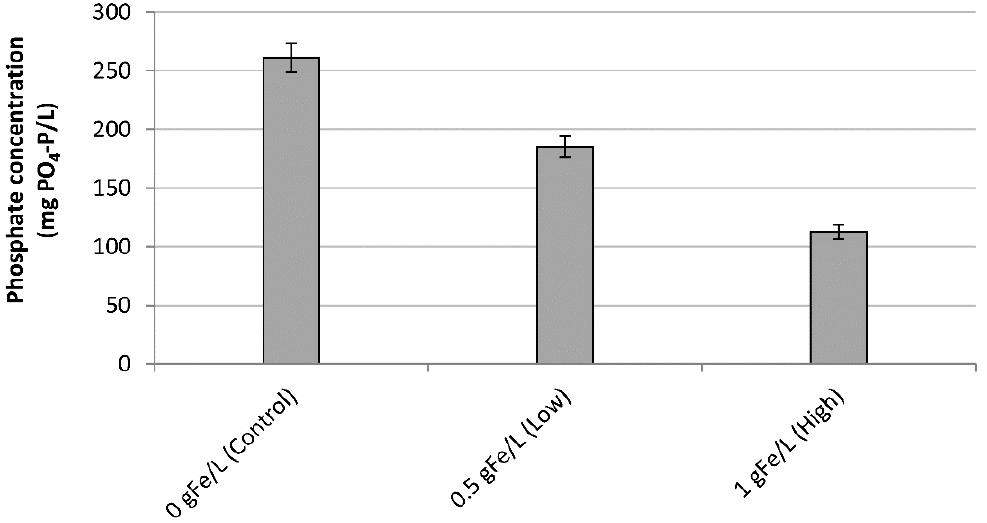
Figure 3. The PO 4 -P concentrations measured in the batch reactors at the end of the batch experiments. The release constituted 261 mg PO 4 -P/L in the control batch, while reductions of 29% and 57% were observed for the reactors dosed with 0.5 g Fe 3+ /L and 1 g Fe 3+ /L of ochre, respectively.